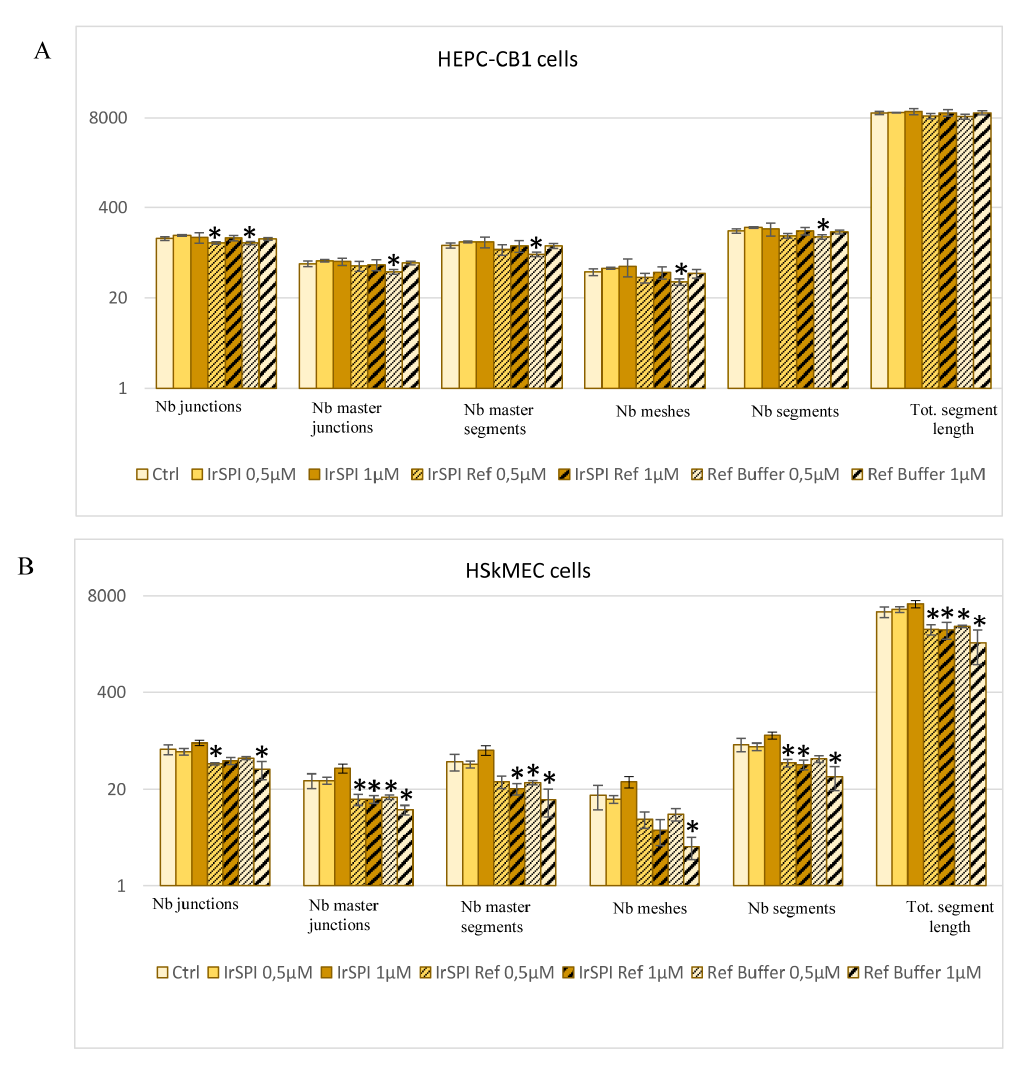
Figure 7. Impact of IrSPI on angiogenesis. ( A ) HEPC-CB1 (human endothelial progenitor cells-cord blood 1) and ( B ) HSkMEC endothelial cells were cultivated with IrSPI prior to (IrSPI), or after a refolding step (IrSPI Ref) for 9.5 h, and the number of junctions, master junctions, segments, master segments, meshes, and total segment lengths were recorded via video-microscopy every 30 min and analyzed with ImageJ software. Results are expressed as means of triplicates. Controls correspond to culture medium (ctrl) and refolding buffer (Ref buffer). Asterisks (*) indicate significant differences as determined using the Student’s t test ( p < 0.05).